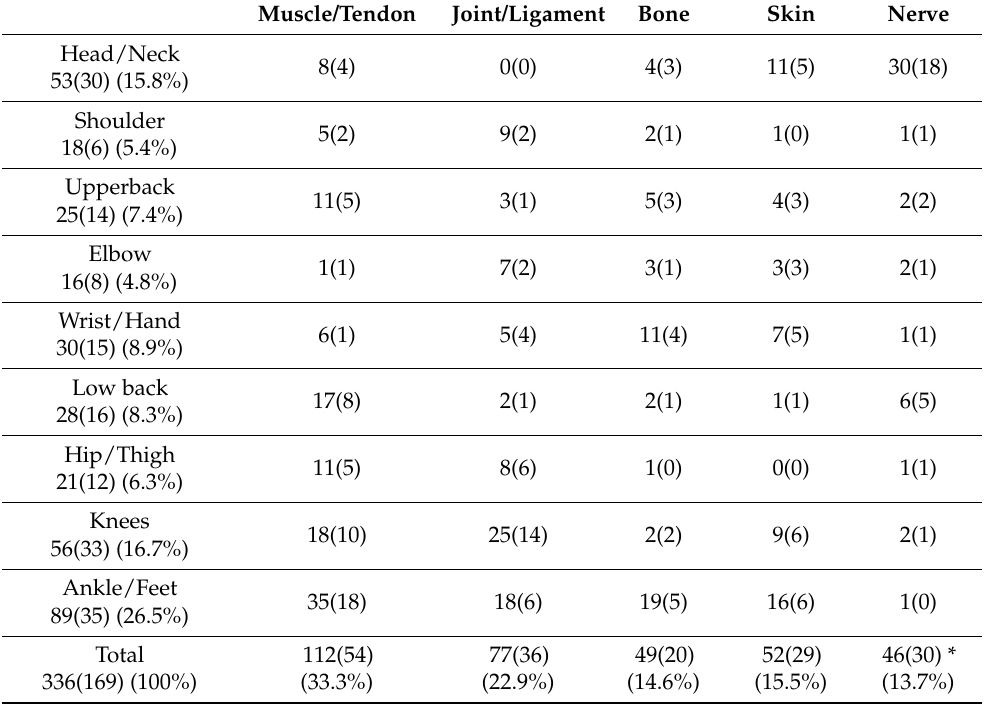
Table 2. Location and type of injuries in collegiate water-ski athletes. Muscle/Tendon Joint/Ligament Bone Nerve